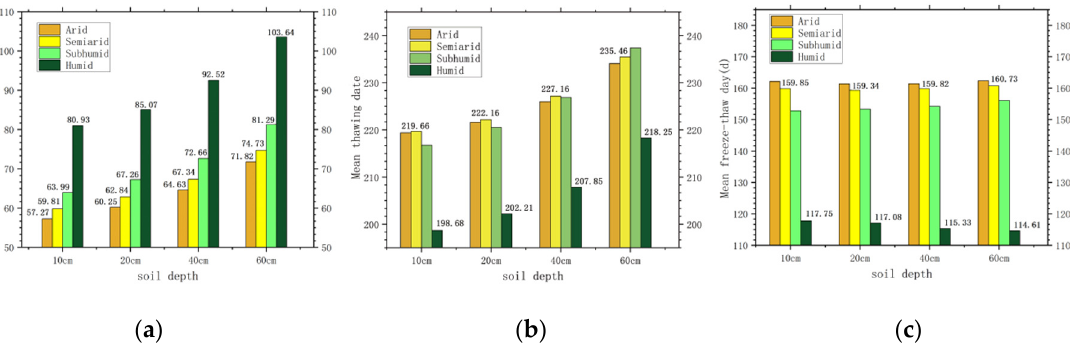
Figure 13. Multi-year means of the ( a ) freezing date, ( b ) thawing date, and ( c ) freeze–thaw duration at four different soil depths from 1980 to 2016, plotted with respect to climate zone (unit: day).